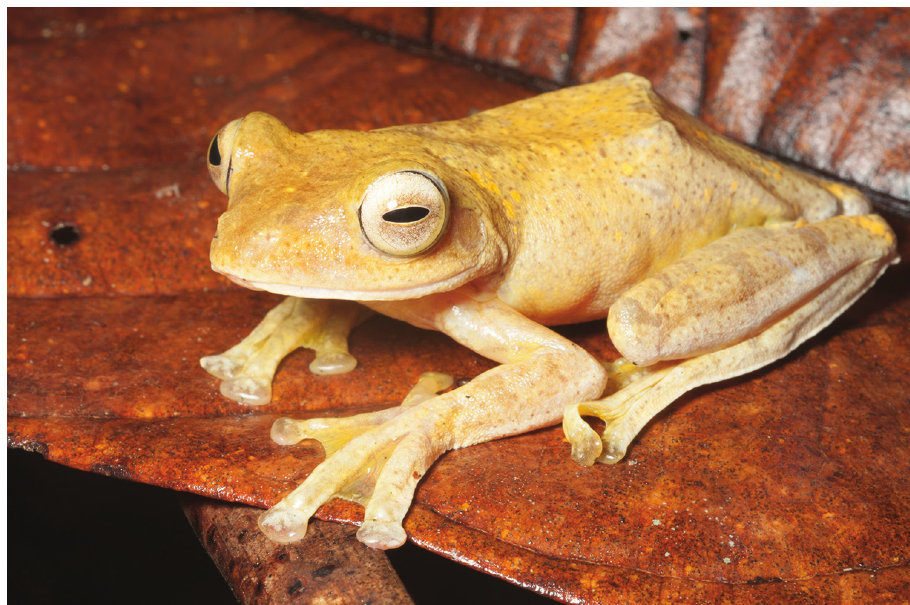
Figure 37. Rhacophorus pardalis has been recorded from Agusan del Sur Province and Camiguin Sur Island. Photo: RMB (from the Municipality of Burauen, Leyte Island; specimen deposited at